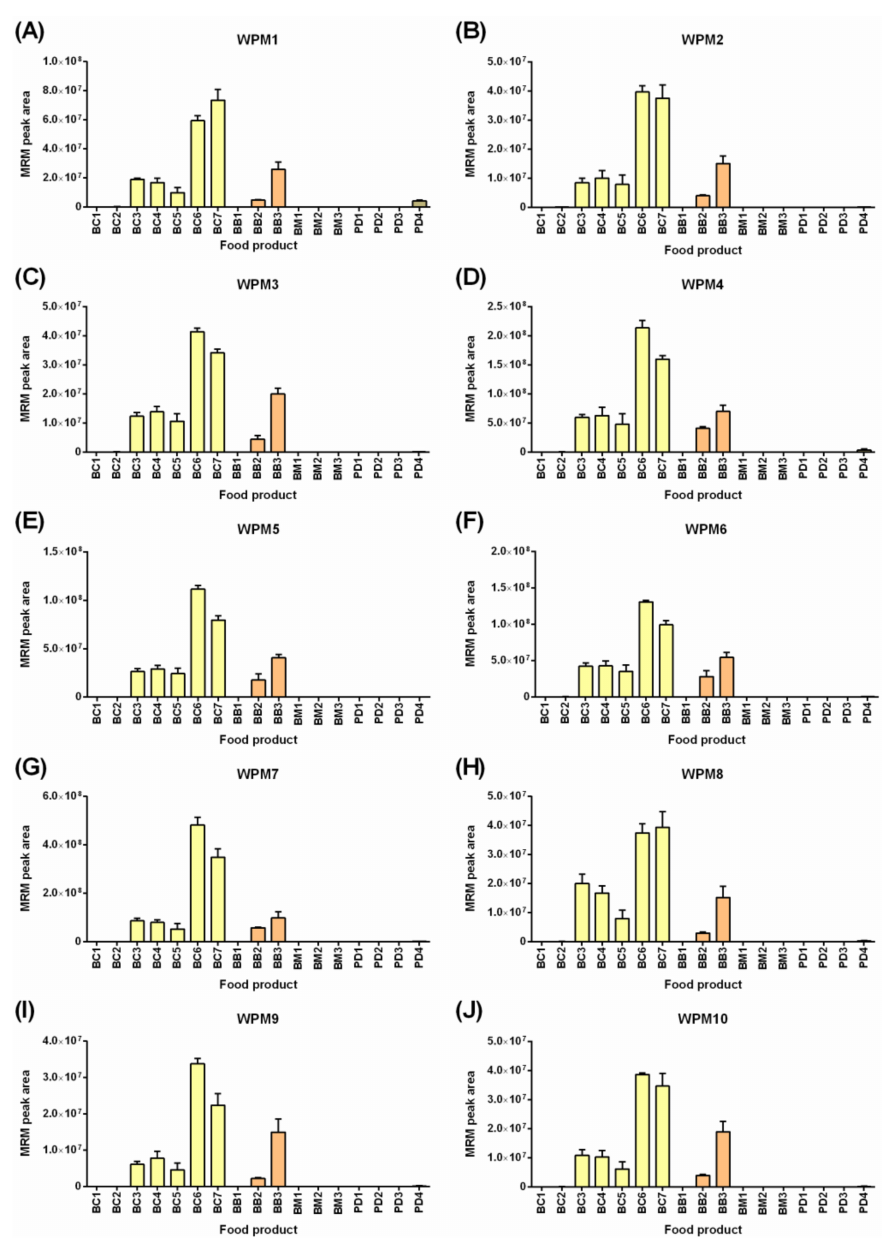
Figure 2. LC-MRM-MS analysis of 10 wheat peptide markers (WPMs) across a range of commercial Australian breakfast food products. The peak area + SD is plotted ( n = 4). Panels ( A ) through ( J ) refer to the ten WPMs defined in Table